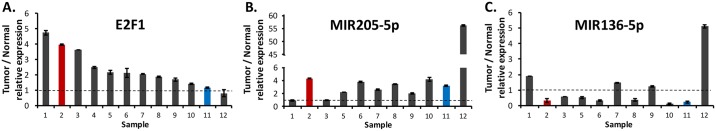
E2F1 and miRNA expression in a set of patient samples.A) E2F1 expression in tumor relative to normal tissue was evaluated by qPCR; PUM1 and HMBS expression were used for normalization. B) MIR205-5p and C) MIR136-5p tumor expression relative to normal expression was evaluated by qPCR; RNU6b expression was used for normalization. Red: patient #2 carries a somatic mutation at E2F1:MIR136-5p target site. Blue: patient #11 carries a germline alteration at E2F1:MIR205-5p target site. Dashed line represents the same expression value between normal and tumor tissues. Error bars indicate the SEM of experiments in triplicate.